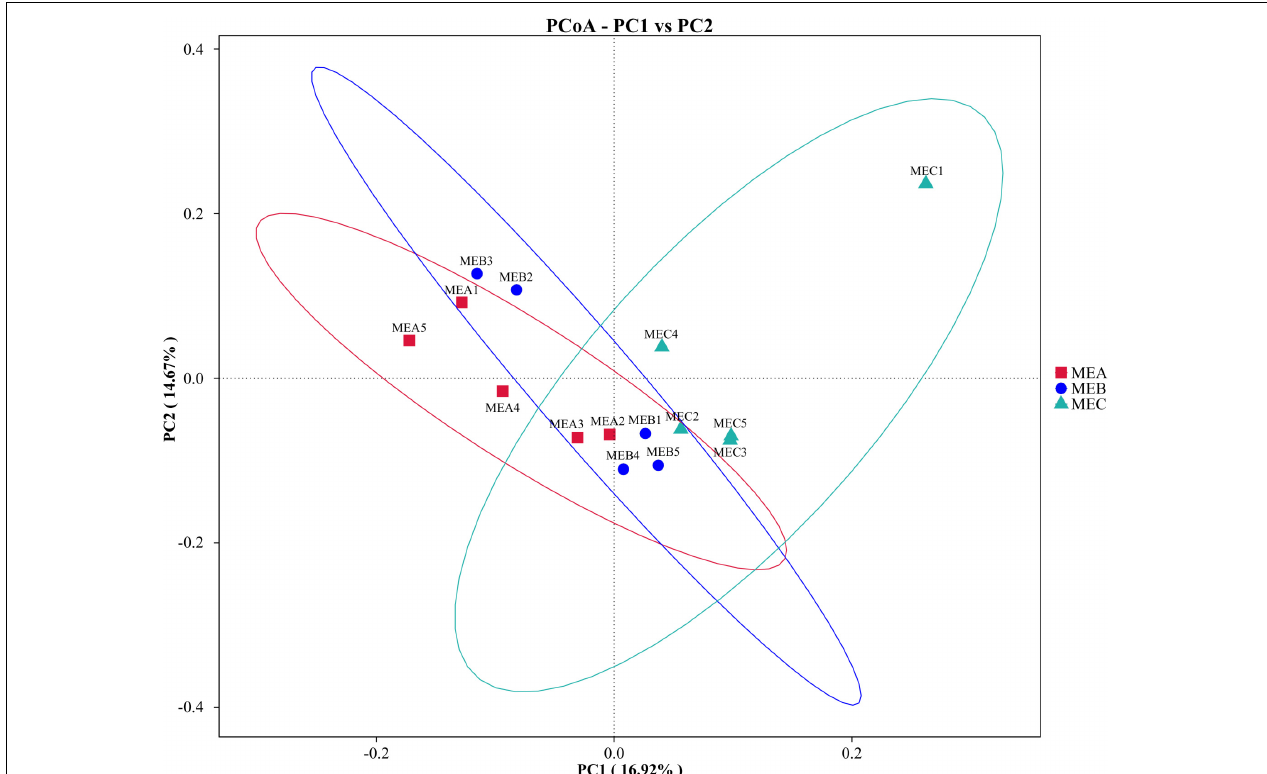
FIGURE 3 | Principal coordinate analysis (PCoA) of low-, medium-, and high-energy diets based on unweighted UniFrac distances. MEA1 to MEA5 in group MEA (red); MEB1 to MEB5 in group MEB (blue); and MEC1 to MEC5 in group MEC (green). PC, percent variation explained by the